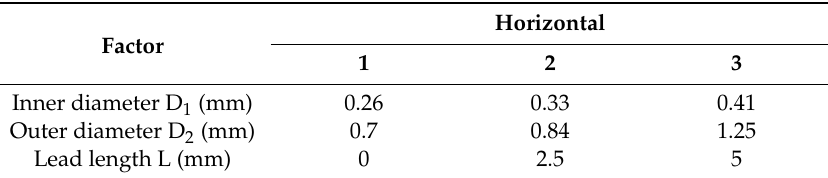
Table 1. Factors and levels of orthogonal test.